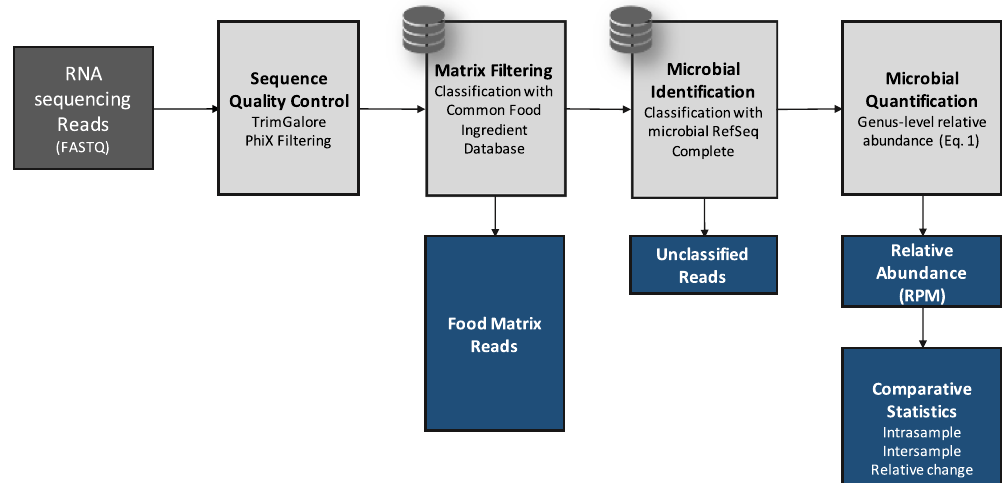
Fig. 1 Bioinformatic pipeline schematic for processing microbiome samples in the presence of matrix content. Description of the bioinformatic steps (light gray) applied to high protein powder metatranscriptome samples (dark gray). Black arrows indicate data fl ow and blue boxes describe outputs from the